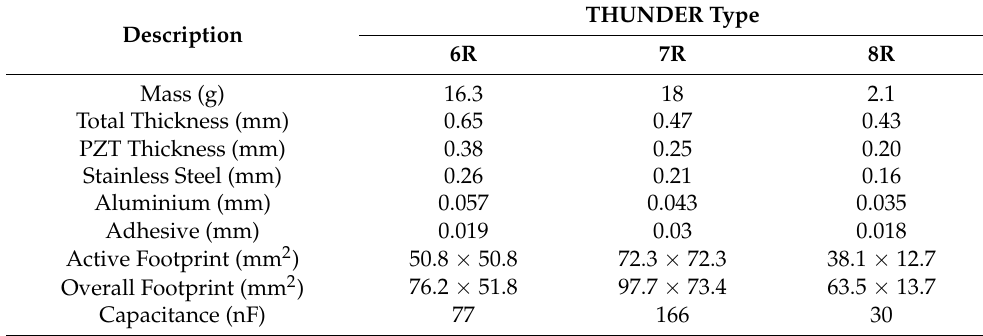
Table 1. Description of thin layer unimorph ferroelectric driver (THUNDER) devices.